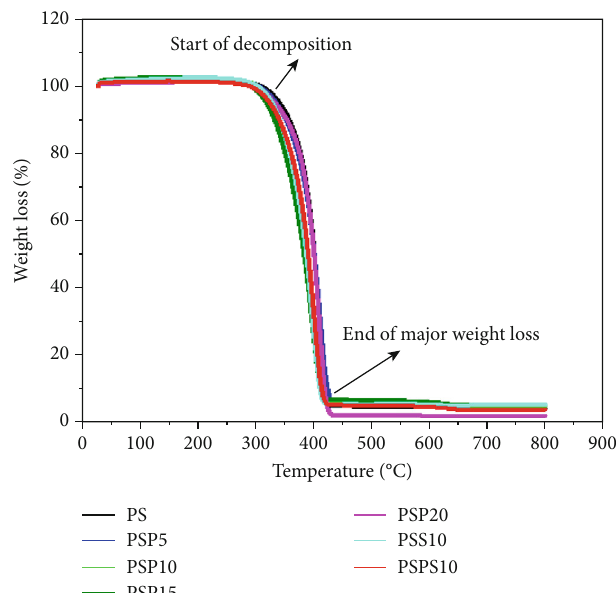
Figure 3: TGA thermographs of the polymer blend samples. Table 2: Decomposition temperature ( T d ) and melting temperature ( T m ) of blends (PS, PSP5-20, PSS10, and PSPS10). Samples